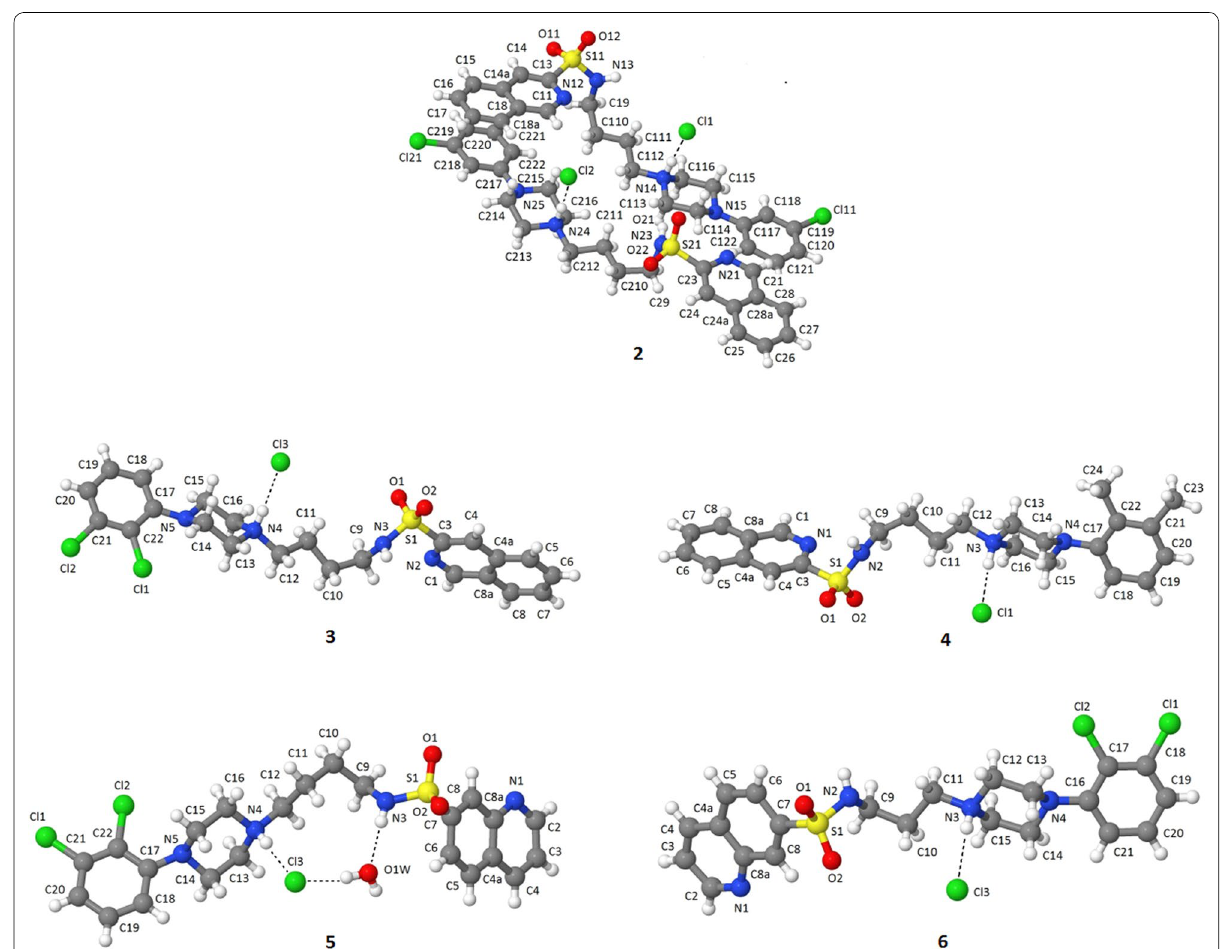
Fig. 2 Molecular geometry of crystal structures, showing the atom labelling scheme. Dashed lines represent a charge-assisted hydrogen